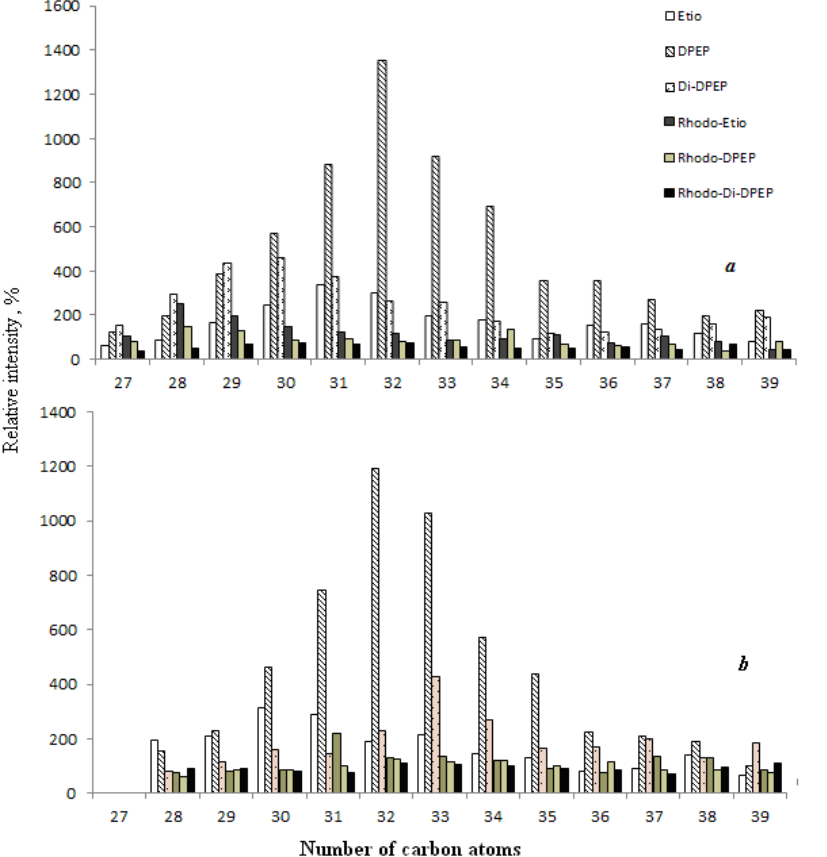
Figure 7. Distribution of various types of vanadyl porphyrins in pVP from DMF extract from the resins of HO nos. 1 ( а ) and 2 ( b ) according to the data of MALDI-TOF mass spectra. The diagram (Figures 8 and 9) shows the relative abundance (in %) of various types of VPs in pVP from the resins of HO nos. 1 and 2.